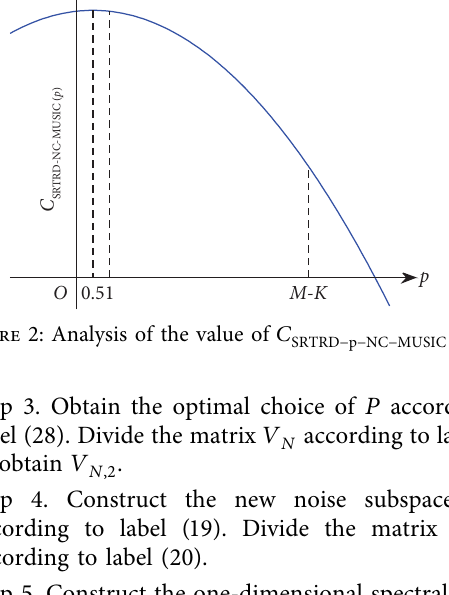
( p ) SRTRD − p − NC − MUSIC